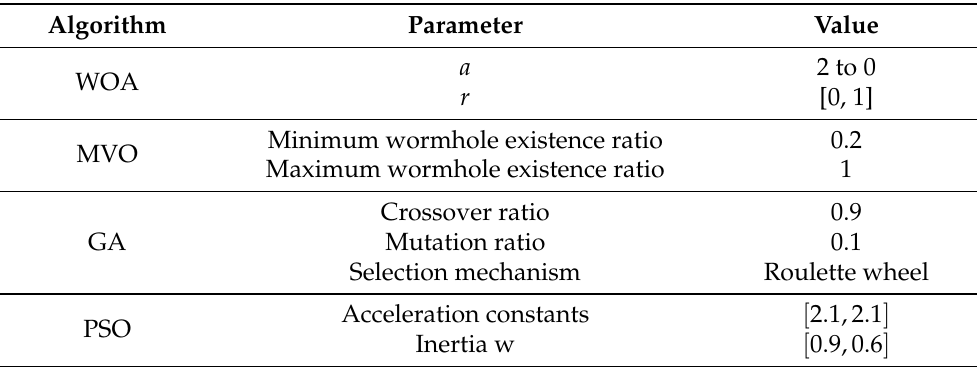
Table 3. Initial parameters of the meta-heuristic